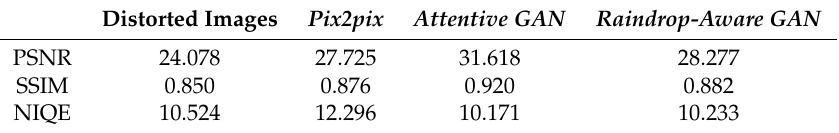
Table 1. Accuracy and image-quality assessment of the two baseline models and our proposed